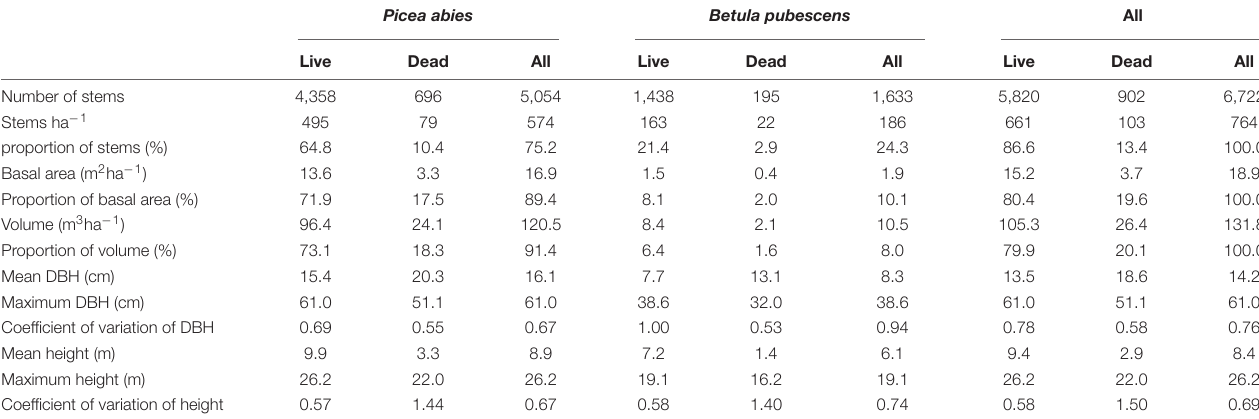
TABLE 1 | Basic statistics of trees in the study area by tree species and